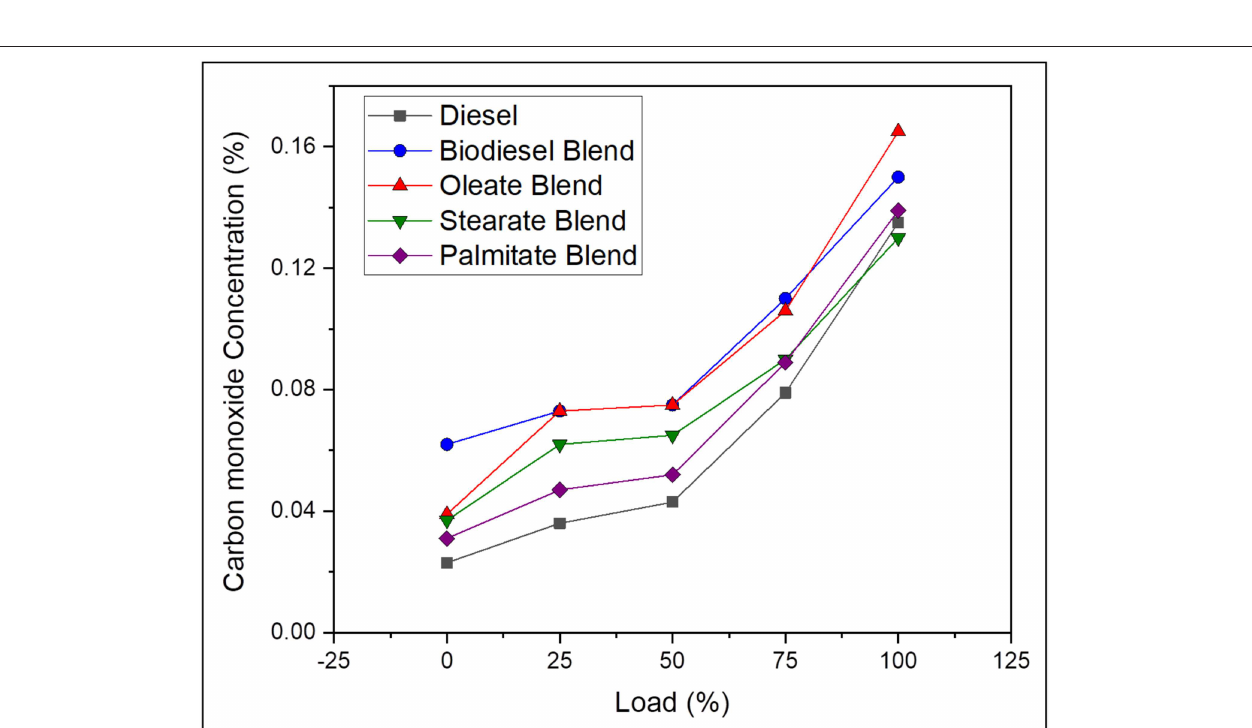
FIGURE 5 | CO emission concentration of diesel and blend samples for varying load conditions.